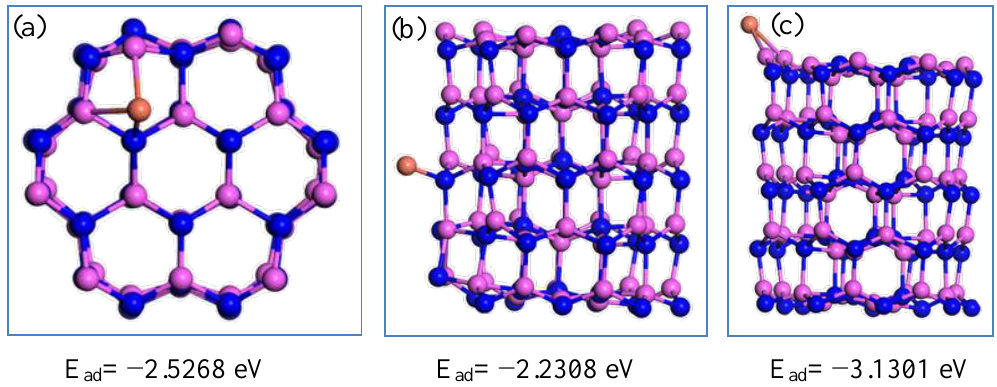
Figure 6. The chemisorption of Cu at different sites of the Al 60 N 60 cluster. The Al, N and Cu atoms are shown in pink, blue and orange. The Cu atom is located at the top, side and edge position of Al 60 N 60 cluster shown in a (top view), b and c , respectively.